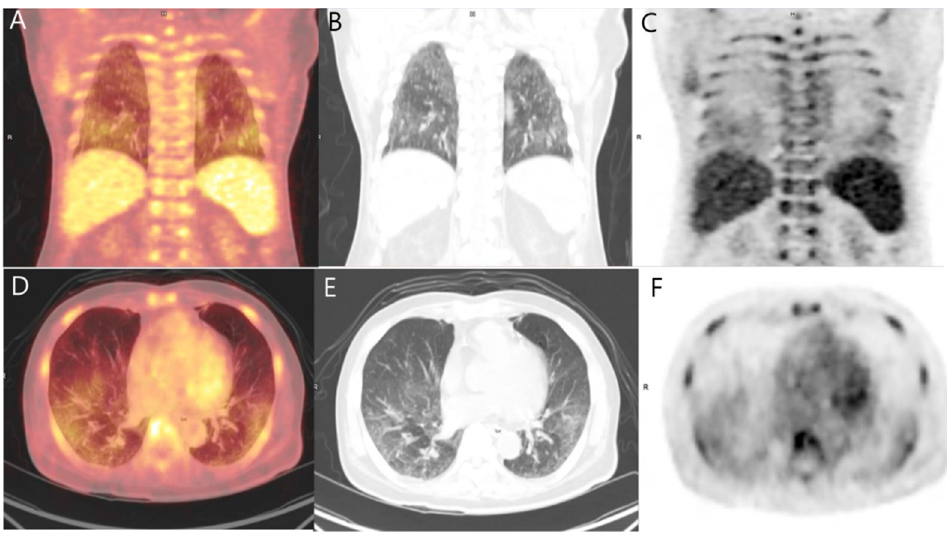
Figure 1. 18 F-FDG PET/CT coronal ( A ,B, C ) and axial ( D ,E, F ) images of the thorax demonstrated bilateral high-grade uptake in the posterior and inferior aspect of the lungs and diffuse low-grade uptake in the remainder of the lungs. Non-contrast CT image of PET/CT ( B , E ) revealed diffuse, hazy ground-glass opacities in the bilateral lower lungs.